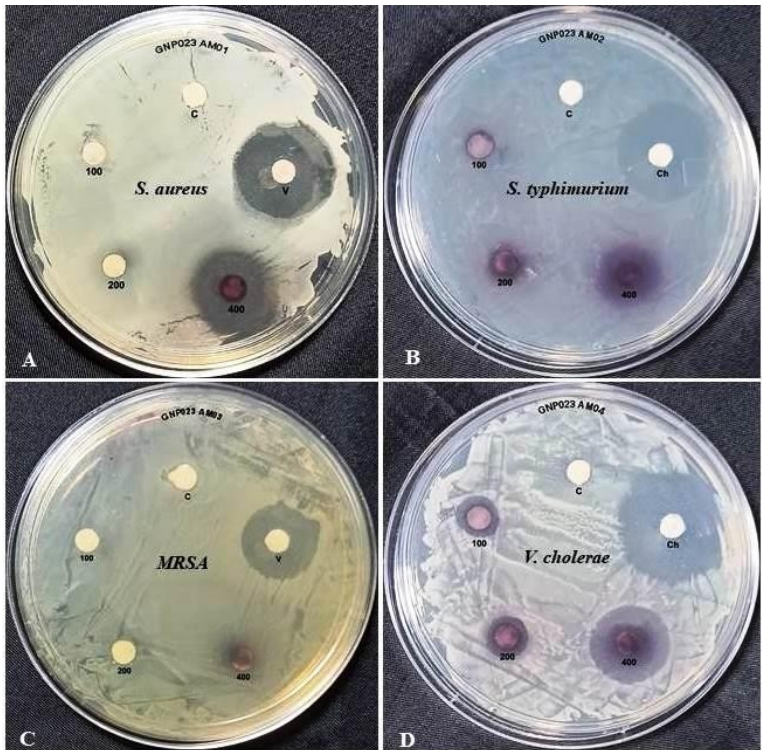
Figure 8. Zones of inhibition produced by GNP023 against bacterial pathogens ( A )— S. aureus , ( B )— S. typhimurium , ( C )—Methicillin resistant S. aureus (MRSA) and ( D )— V. cholerae. [V–Vancomycin; Ch—Chloramphenicol; 100—GNP023 100 μ g/mL; 200—GNP023 200 μ g/mL; 400—GNP023 400 μ g/mL; C—Control]. Table 2. Antimicrobial activity of gold nanoparticle GNP023. Diameter of Zone of Inhibition (mm) *Against Pathogenic Bacte- ria Concentrations